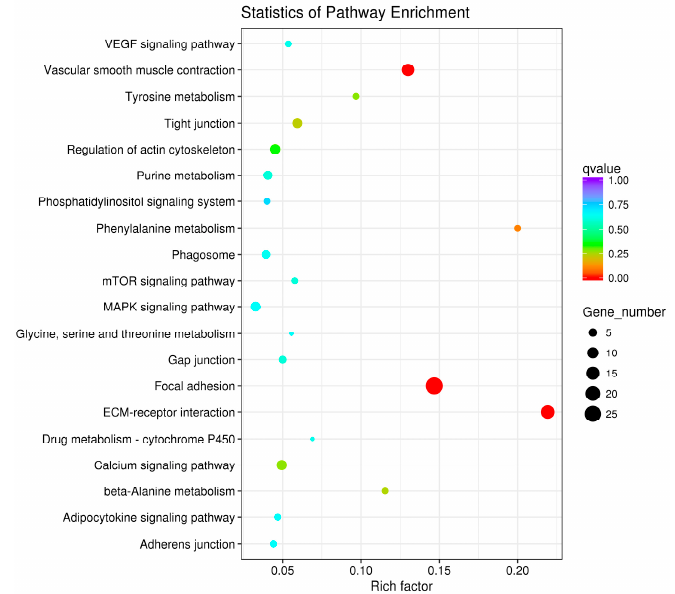
Figure 9. KEGG Analyses of the ovarian DEGs.